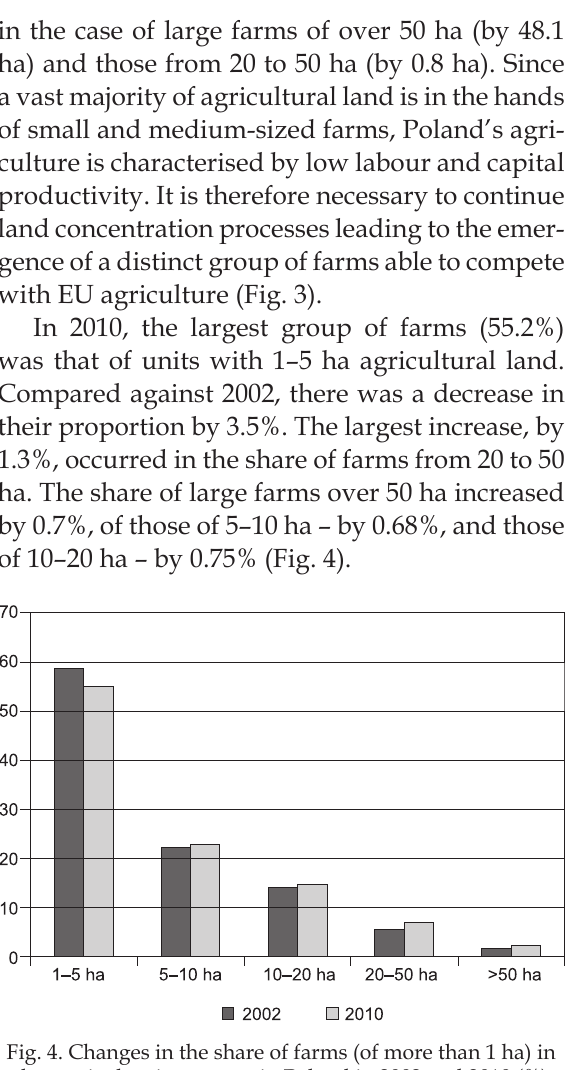
Fig. 3. Average farm size in 2002 and 2010 (ha) Source: authors’ own calculation based on German 2011 data and Polish 2002 and 2010 Agricultural Censuses